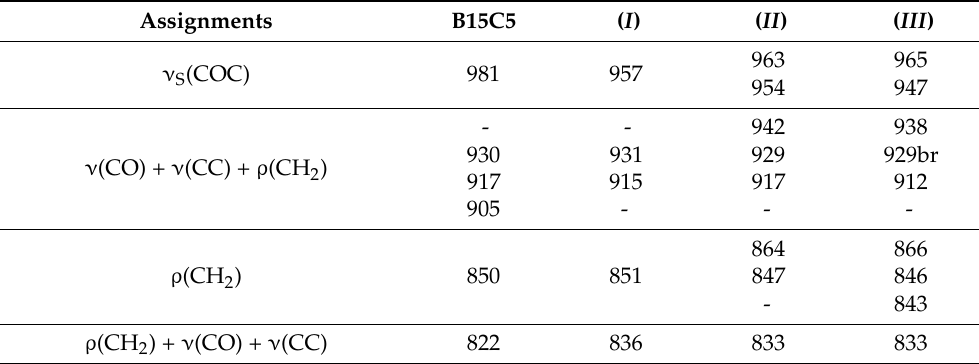
Table 1. Vibration frequencies of ethylene glycol groups of B15C5 in complexes ( I–III ) and free ligand in FTIR spectra (cm − 1 ).